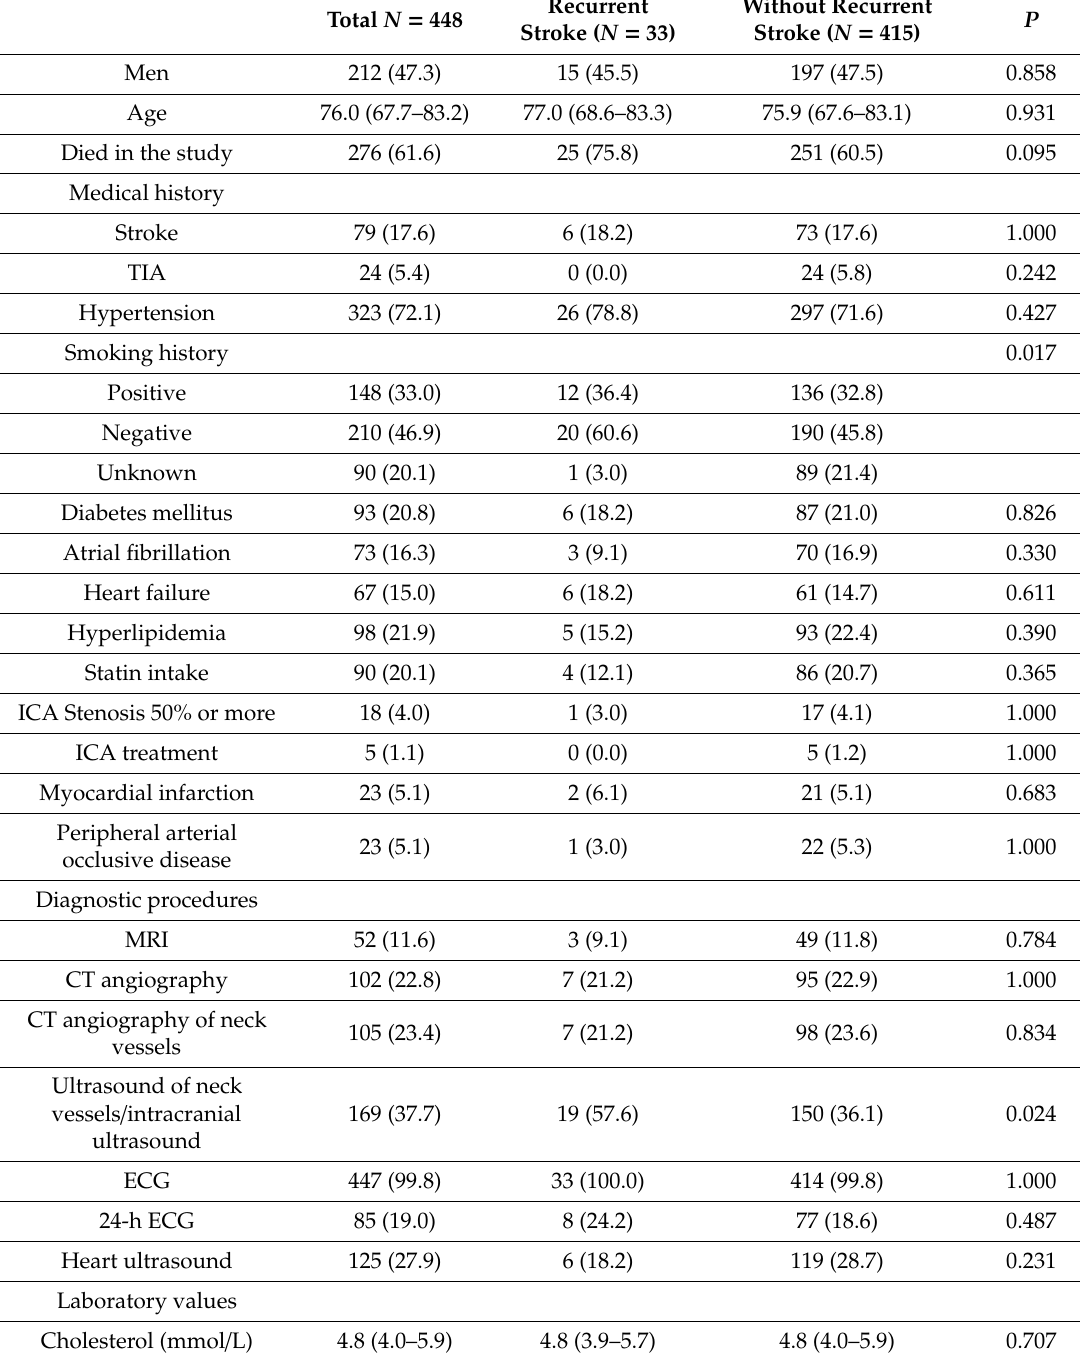
Table 3. Demographic, historical, laboratory, and stroke etiological data of the 448 patients hospitalized due to ischemic stroke in the period 9 / 2011–10 / 2012 according to presence of recurrent stroke / transitory ischemic